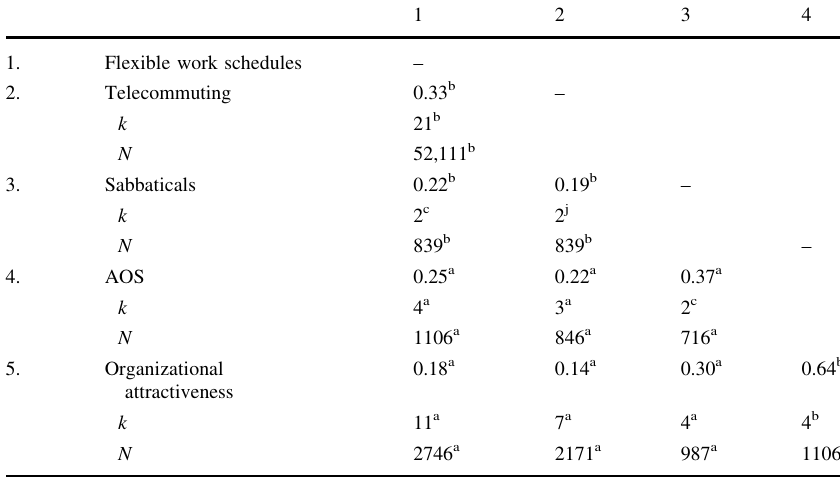
Table 4 Meta-analytic correlations between FWPs and external